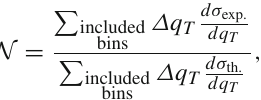
Fig. 7 Theoretical error-bands and experimental data points for E288 (400 GeV) experiment at 13–14 GeV. The theoretical error is estimated changing c 1 , 2 , 3 , 4 in the range ( 0 . 5 , 2 ) at each perturbative order. The